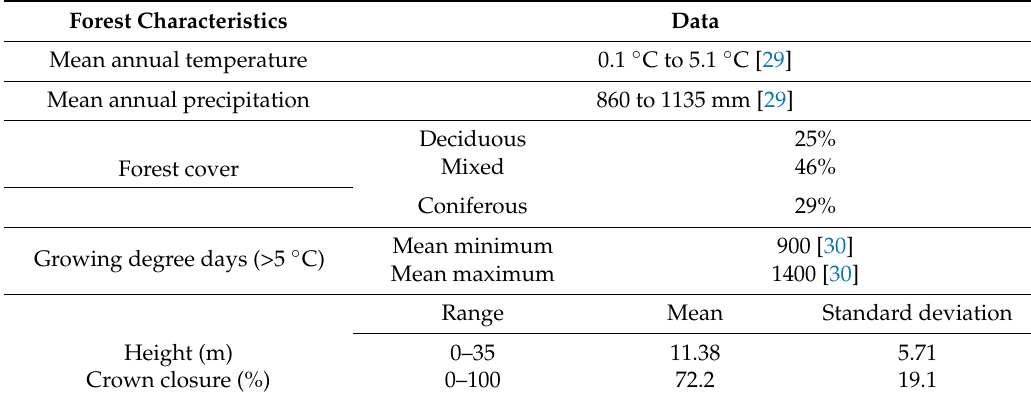
Table 1. Main forest characteristics.